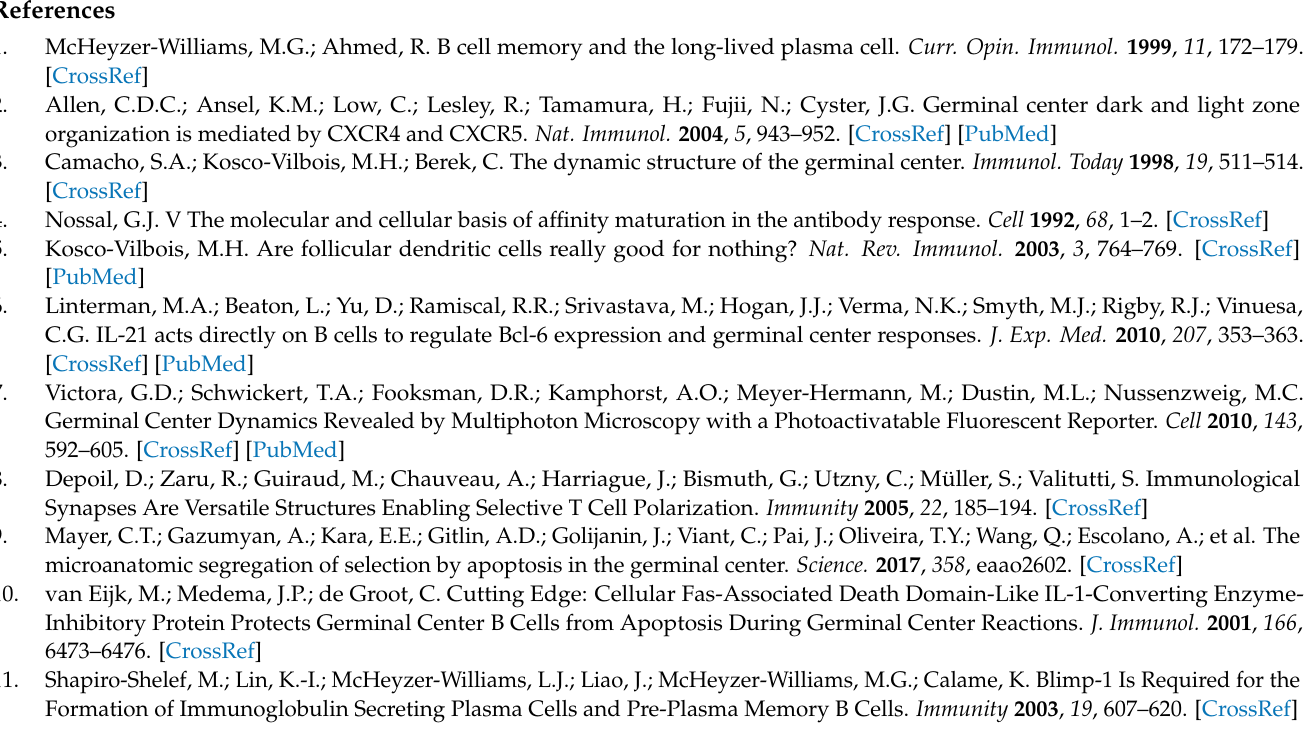
equal proportions as in Figure S2 but with faster plasma cell differentiation corresponding to half-life of 12 days; Figure S10: Impact of GC–GC interactions with two epitopes in equal proportions as in Figure S2 but with slower plasma cell differentiation corresponding to half-life of 48 days; Figure S11: Impact of GC–GC interactions with two epitopes in equal proportions as in Figure S2 but with lower recycling probability (0.6); Figure S12: Impact of GC–GC interactions with two epitopes in equal proportions as in Figure S2 but with lower recycling probability (0.8); Figure S13: Impact of GC–GC interactions with two epitopes in equal proportions as in Figure S2 but with shorter antibody half-life (7 days); Figure S14: Impact of GC–GC interactions with two epitopes in equal proportions as in Figure S2 but with longer antibody half-life (21 days); Figure S15: Effect of GC–GC interactions as in Figure 1 but with different seeder